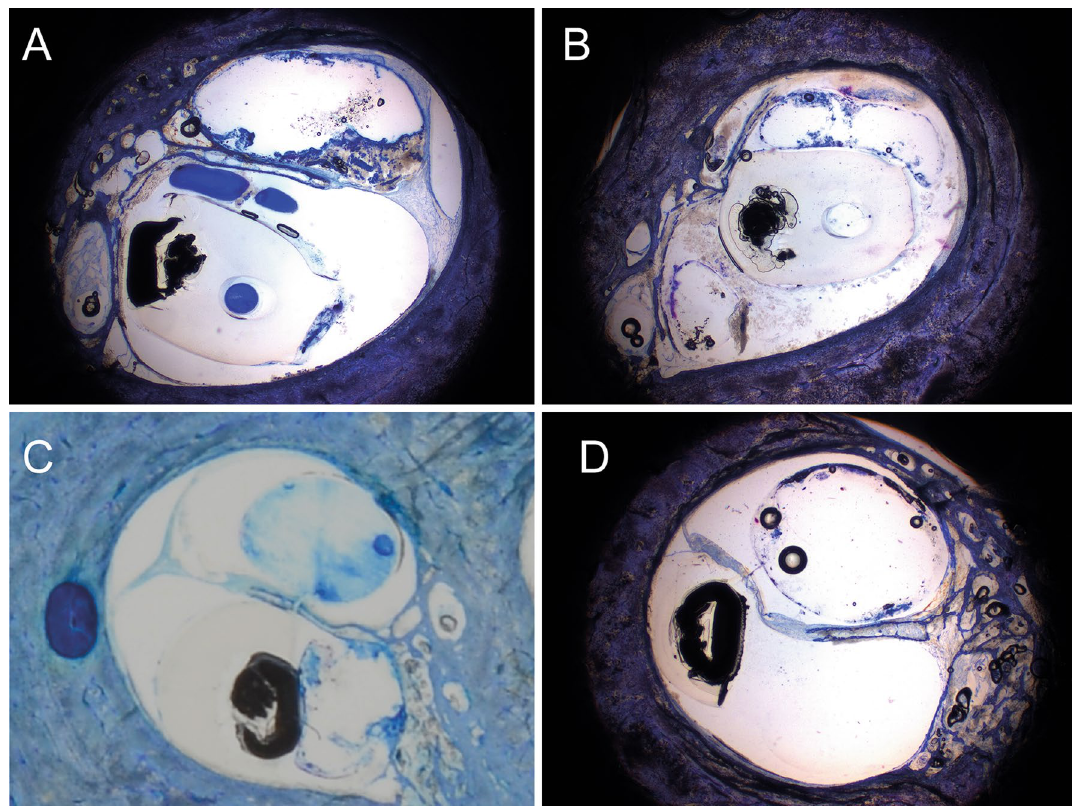
Figure 4. Histological modiolar plane sections. ( A ) non-STL PM array. ( B ) STL array with fracture of osseous spiral lamina. ( C) non-STL LW array. ( D ) STL LW array to scala media with displacement of stria vascularis, basilar membrane and spiral